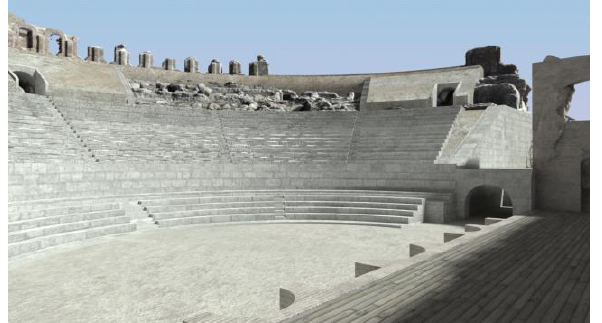
Figure 15. 3D Virtual representation of the restoration proposal: Koilon and